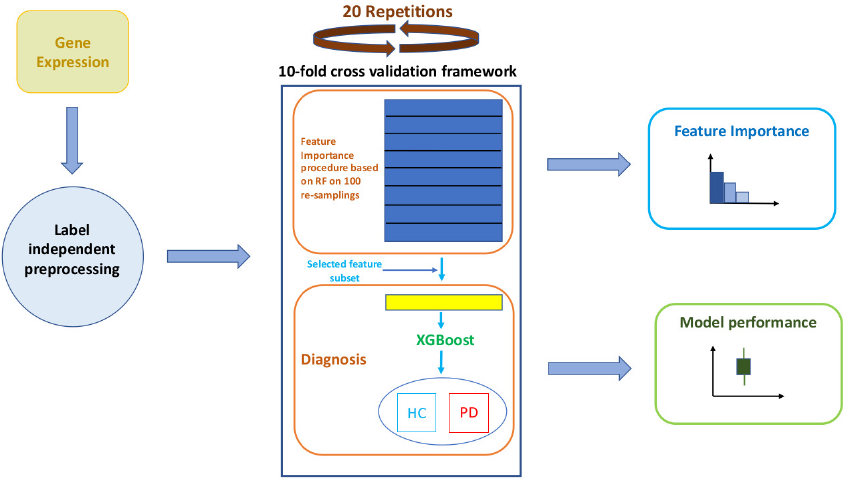
Figure 1. Schematic workflow of the performed analyses. The main phases are: (i) preprocessing, (ii) learning and (iii) performance